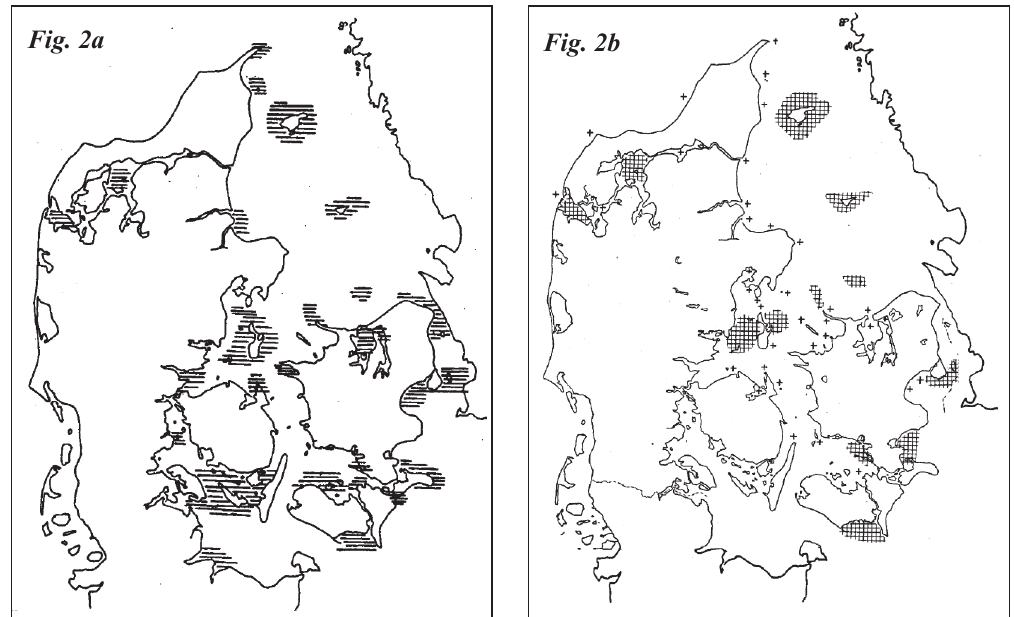
Fig. 2. Estimated distribution of harbour seals in Denmark prior to the onset of the bounty system in 1890 (a) and in the 1970s (b). Highligted areas designate distribution of breeding sites. + designates occasional haul-out observations. Figures modified from Søndergaard et al.